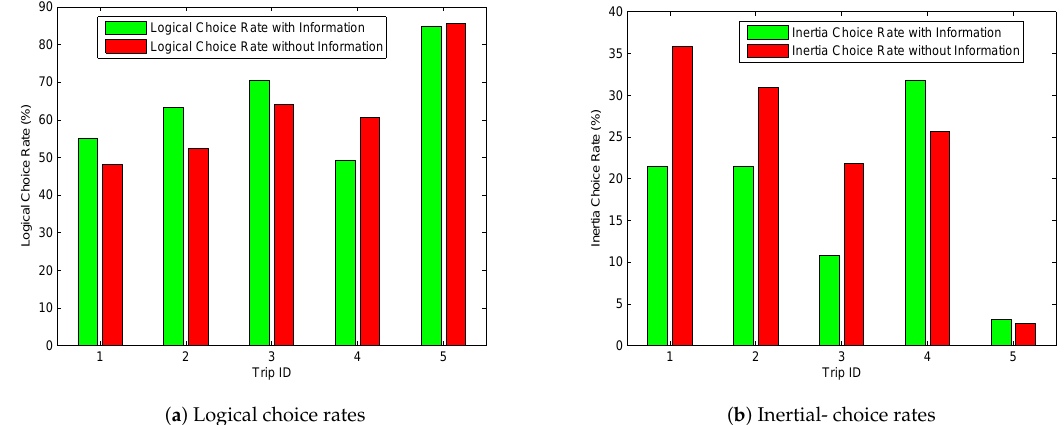
Figure 4. Logical- and inertial- choice rates over